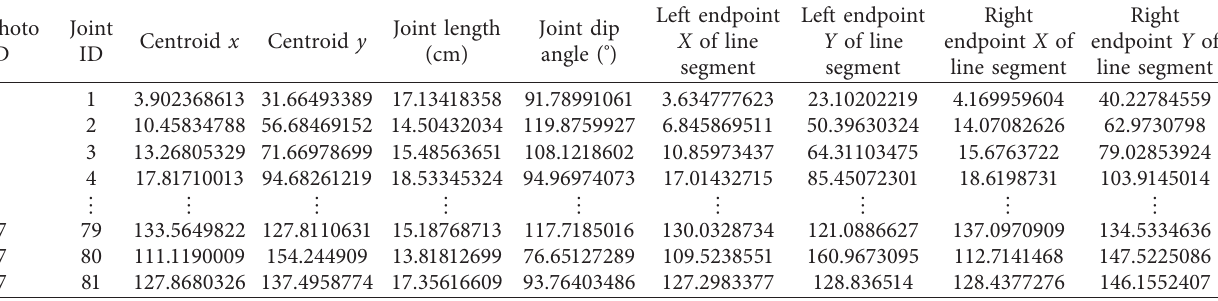
Table 2: Crack parameters in close-up photographs.